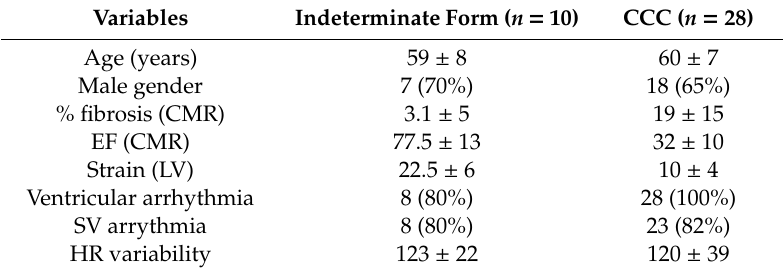
CMR = Cardiovascular magnetic resonance. EF = Ejection fraction. LV = left ventricular. SV = Supraventricular. HR = Heart rate.